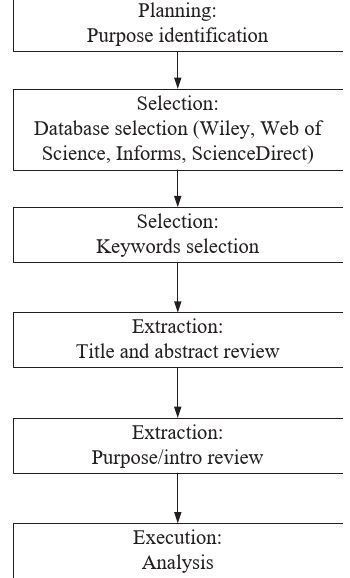
Figure 1. Researchprocess